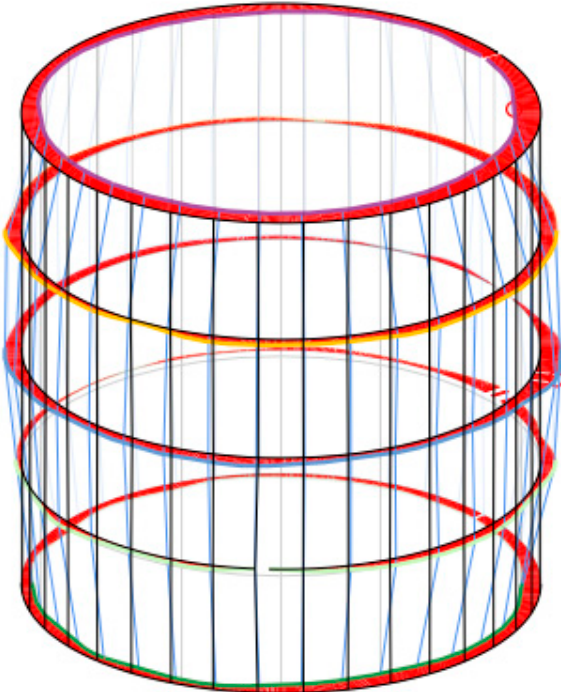
Figure 3. Optical data generated by the coordinate measuring machine for the hole drilled in Experiment No. 6.